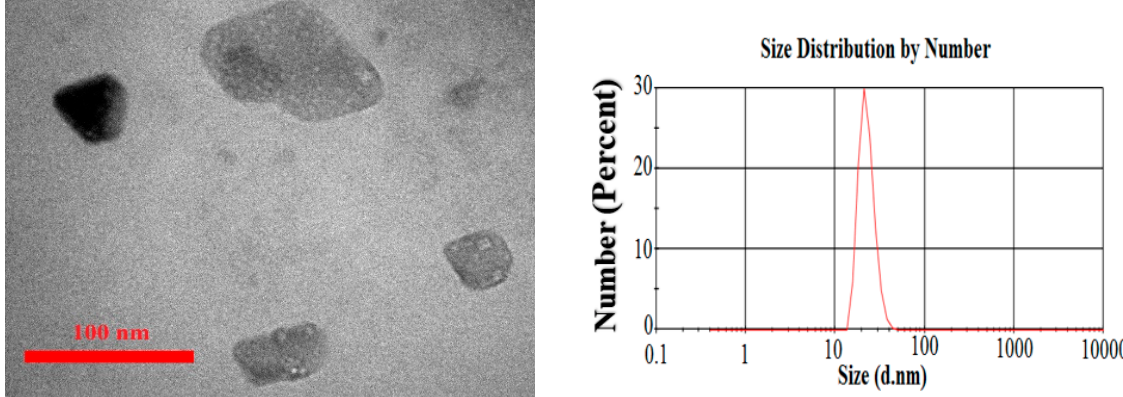
Figure 3. TEM image of sonochemical synthesis of CeO 2 -SA nanoparticles (left), DLS analysis of CeO 2 -SA nanoparticles (right).